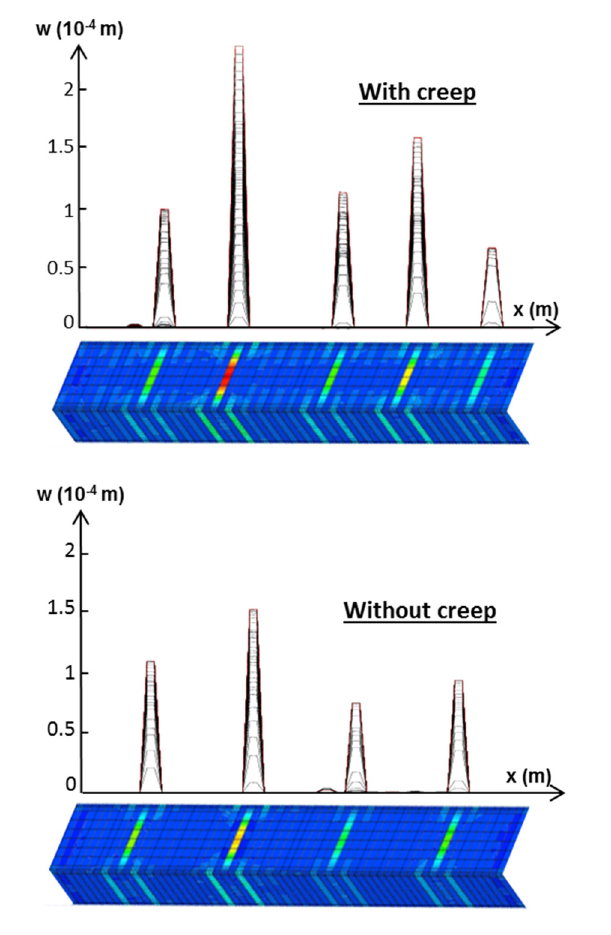
Figure 9. Cracking pattern and crack opening in the restrained tie when creep is considered or